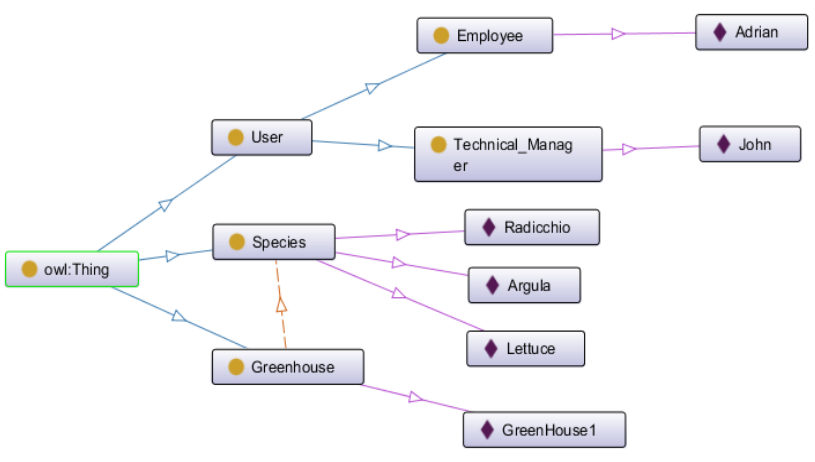
Figure 2. Agrindoor ontology and classes, with some